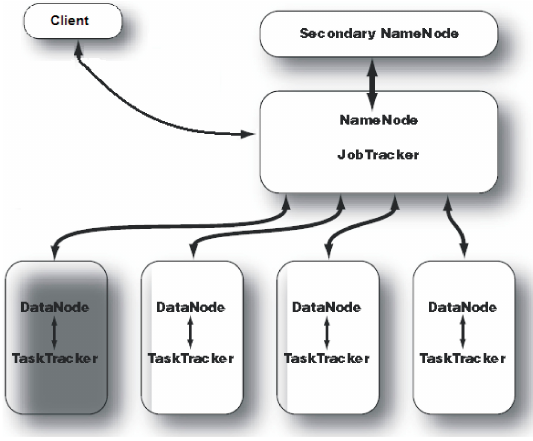
Figure 1. Hadoop cluster architecture.